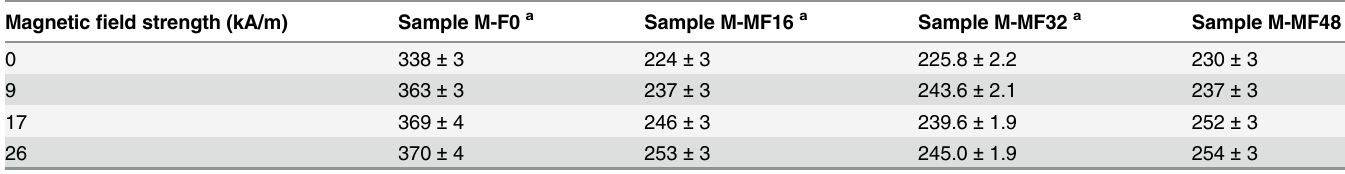
Table 4. Effect of the magnetic field applied during measurement on the shear modulus (Pa) of magnetic tissue substitutes. Data in this table corre- spond to the best linear fit including experimental uncertainties. Magnetic fi eld strength